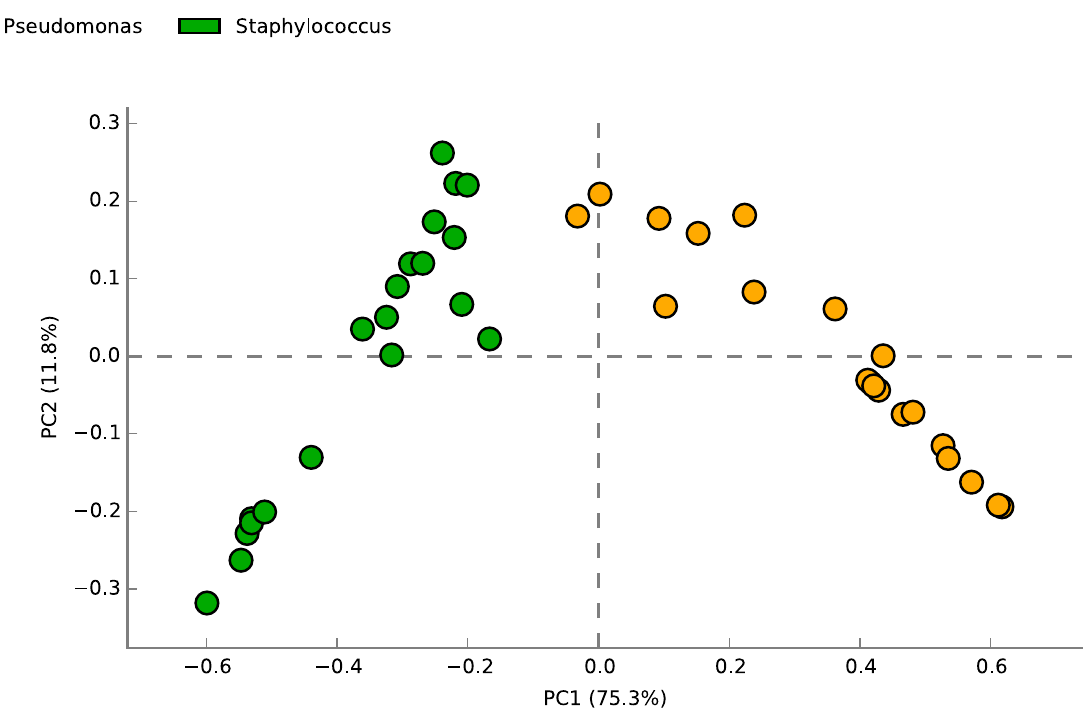
Fig 2. Beta diversity of bacterial community, represented by PCA plot. Dots with the same color mean samples of the same group, n = 20 per group.